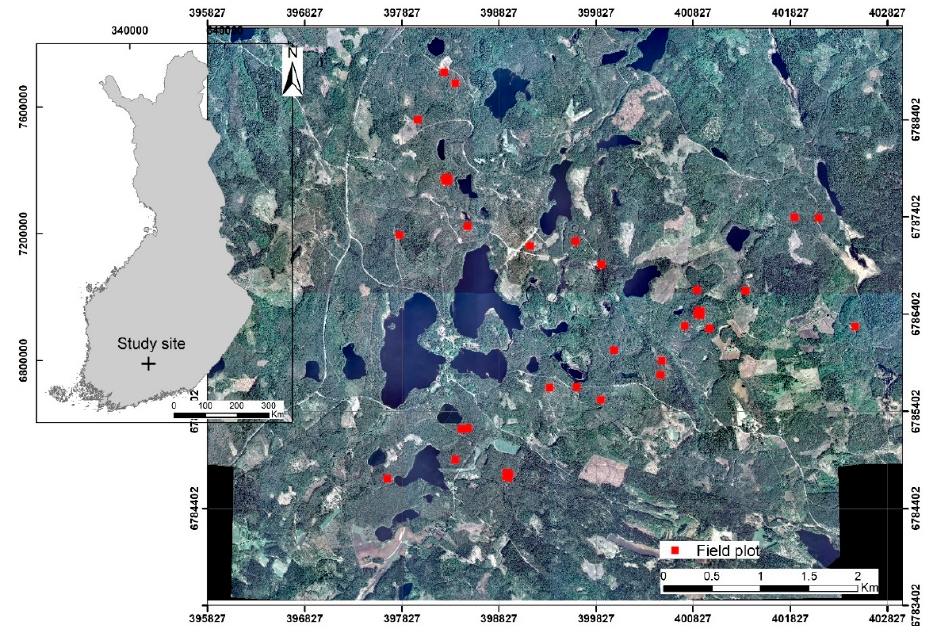
Figure 1. Spatial distribution of 37 sample plots in the study site. The study site is illustrated by aerial imagery (red-green-blue, RGB) obtained in the summer of 2014.